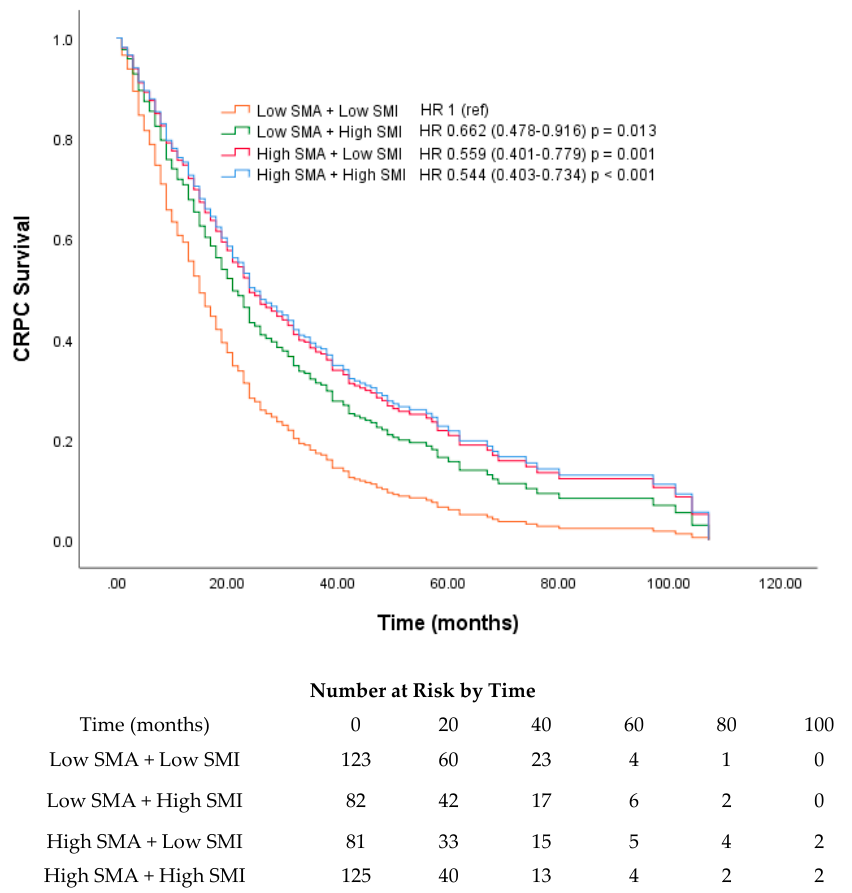
Figure 5. Survival curves based on Cox regression analysis of survival of patients with castration- resistant prostate cancer (CRPC) stratified according to their skeletal muscle phenotypes. castration-resistant prostate cancer (CRPC) stratified according to their skeletal muscle